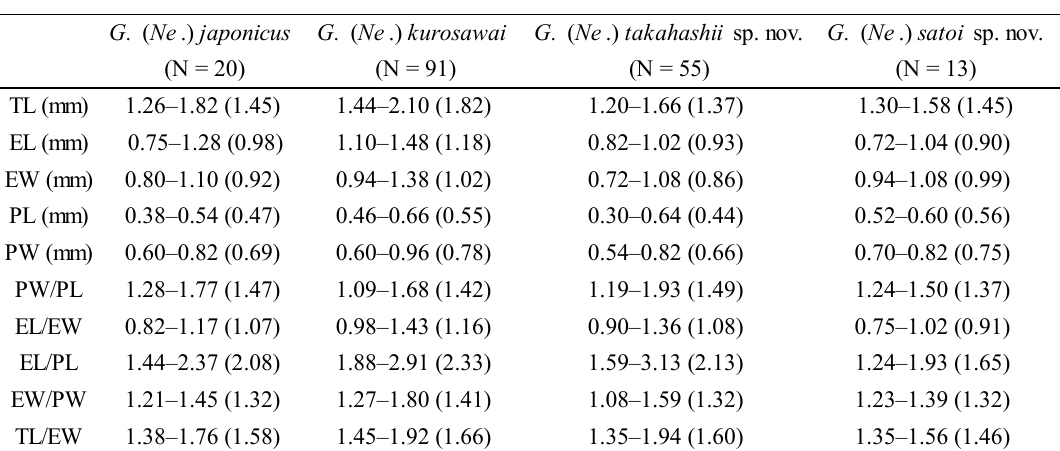
Table 2. Measurements of Georissus ( Neogeorissus )